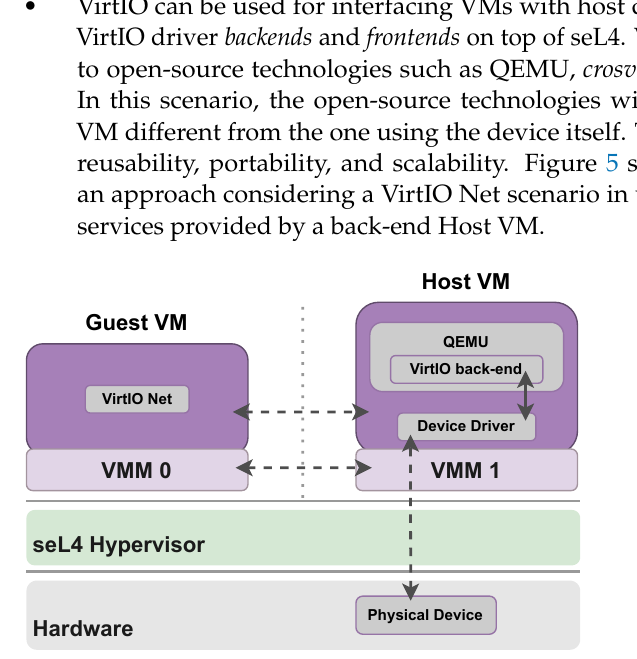
Figure 5. VirtIO drivers example on top of seL4